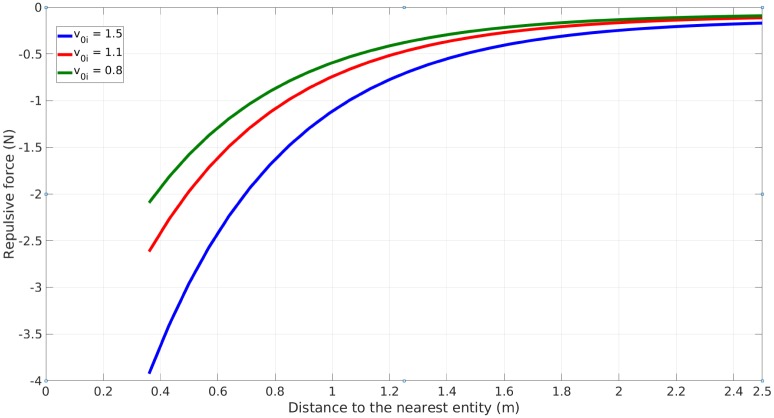
Repulsive force as a function of di.